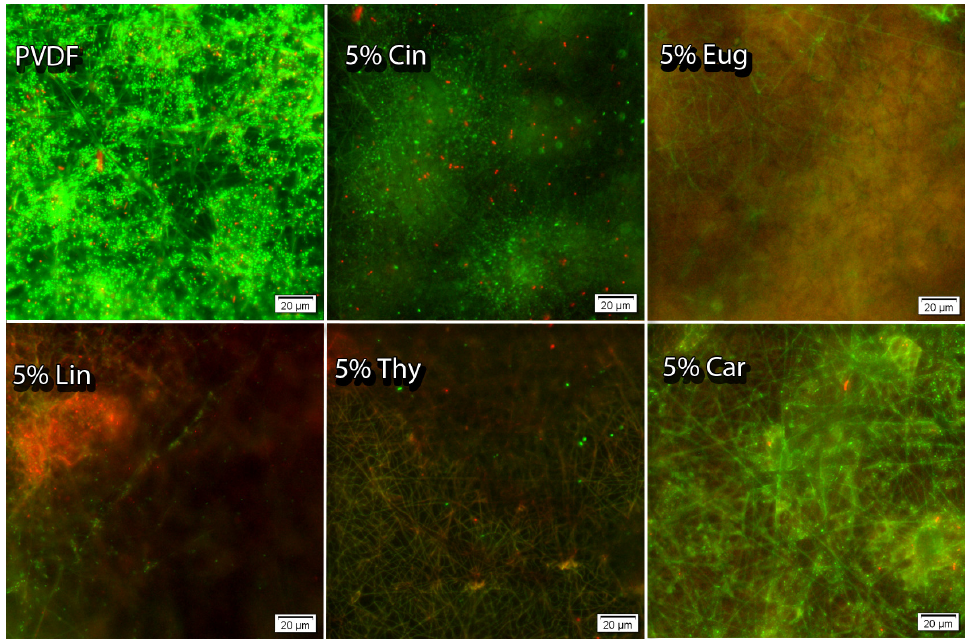
Figure 2. The viability of E. coli presence of PVDF nanofibers with EOs (5 w / w